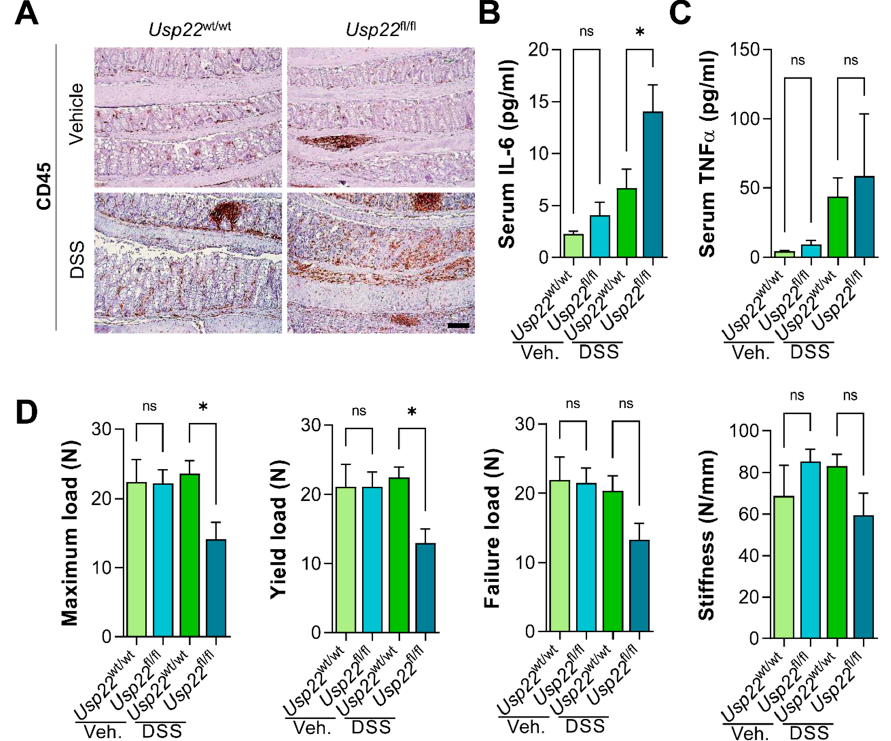
Figure 2. Local immune cell infiltration and systemic inflammation were elevated in Usp22 -deficient mice . ( A ) Immuno- histochemistry (IHC) for CD45-positive cells in the colon revealed increased infiltration of immunoregulatory cells in DSS- treated Villin-Cre, Usp22 fl/fl mice. Scale bar: 100 μ m. ( B ) Usp22 -deficient mice displayed higher serum interleukin 6 (IL-6) levels while ( C ) serum TNF α levels were not significantly affected by genotype. ( D ) Tibia biomechanical properties were determined using a Zwick device. Maximum, yield and failure load as well as bone stiffness were decreased in DSS-treated Usp22 fl/fl mice, indicating higher bone fragility in these animals. Mean ± SEM. One-way ANOVA. * p ≤ 0.05.